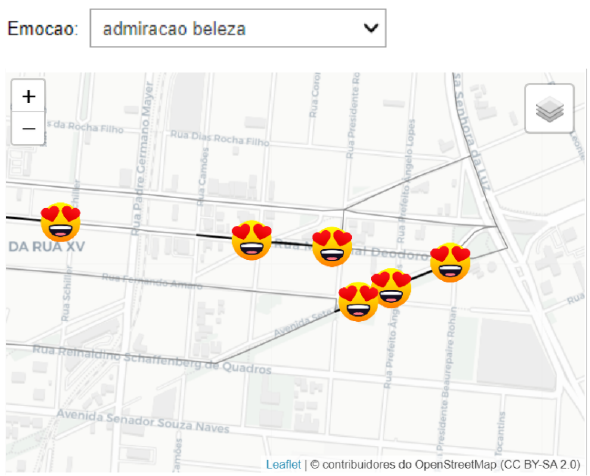
Figure 7 . Streets assigned with the emotion Admiration